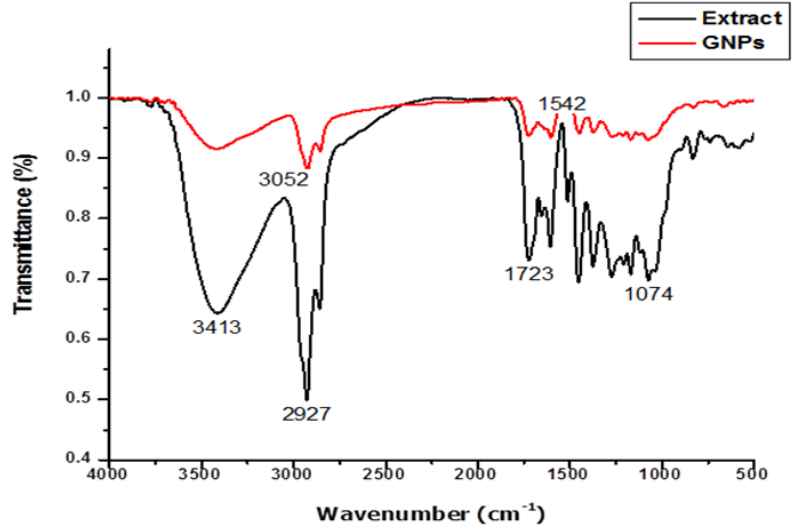
Figure 5. FTIR spectrum of extract and GNPs.